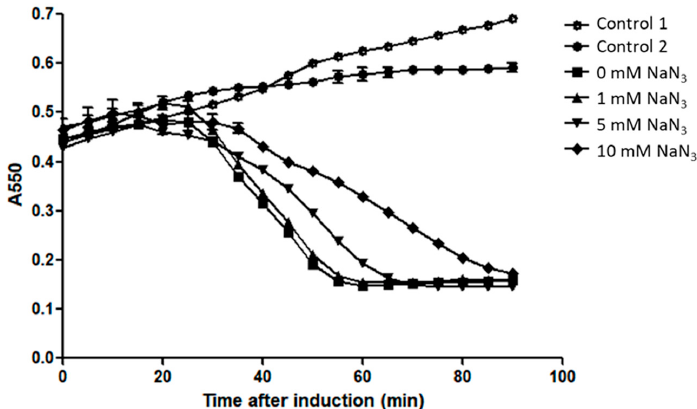
Figure 2. Sec machinery is not involved in M4Lys-mediated cell lysis in vitro. Cell lysis kinetics of M4Lys in the presence of the Sec translocase inhibitor, NaN 3 . In all experiments, expression of M4Lys from pETDuet-1 plasmid in E. coli cells was induced by adding 0.1 mM of IPTG, except for the controls. Open circles, no NaN 3 without IPTG (control 1); closed circles, 10 mM NaN 3 without IPTG (control 2); closed squares, no NaN 3 ; closed triangles, 1 mM NaN 3 ; reverse triangles, 5 mM NaN 3 ; and diamonds, 10 mM NaN 3. All experiments for the cell lysis kinetics were performed in triplicate and the results of each treatment are represented by the mean ± standard deviation.